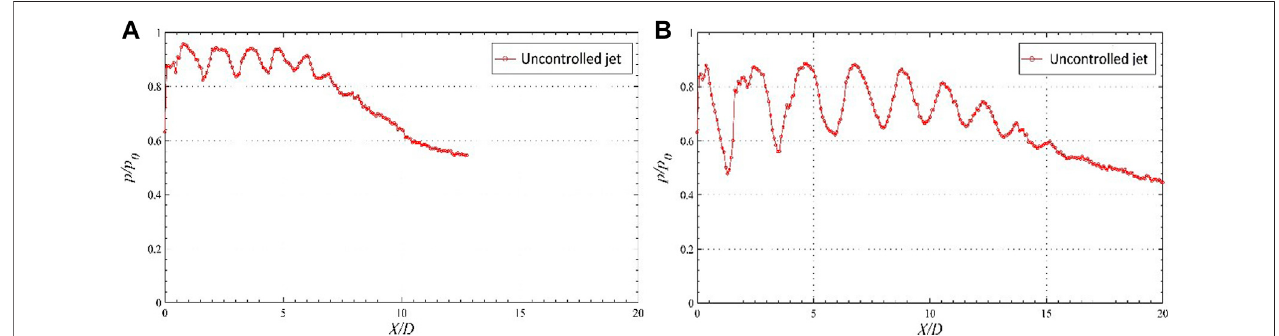
FIGURE 3 | Centerline pressure decay for the uncontrolled Mach 1.75 jet [9].